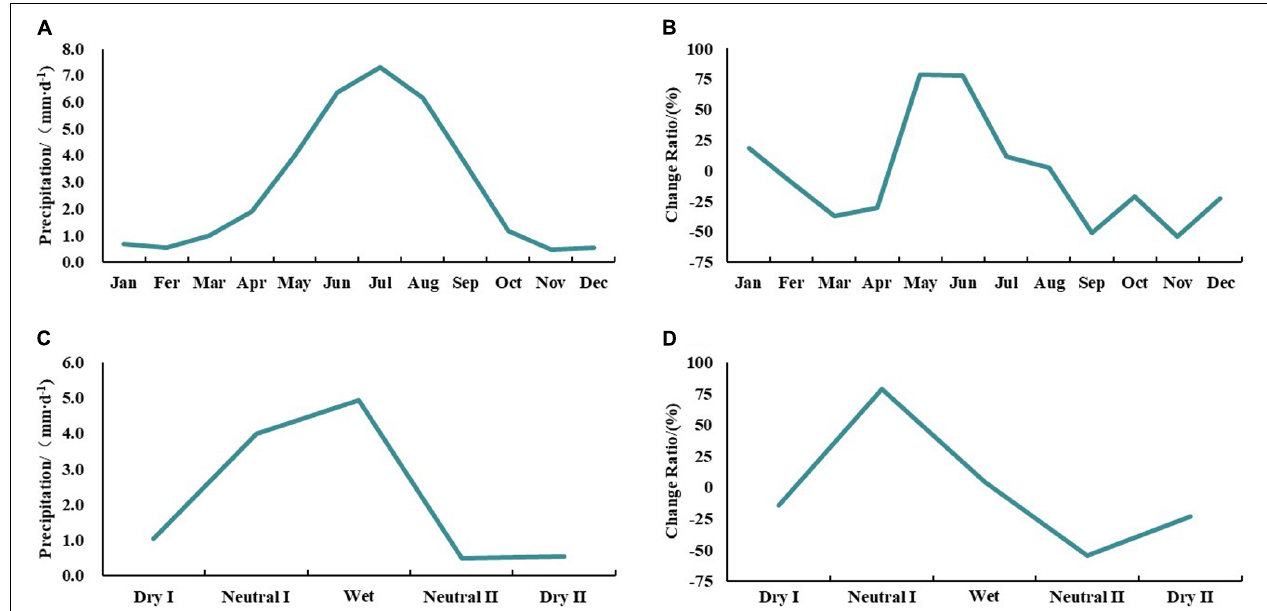
FIGURE 11 | Future precipitation forecasting: (A) future monthly precipitation; (B) monthly precipitation change; (C) future precipitation in period; (D) precipitation change in period.